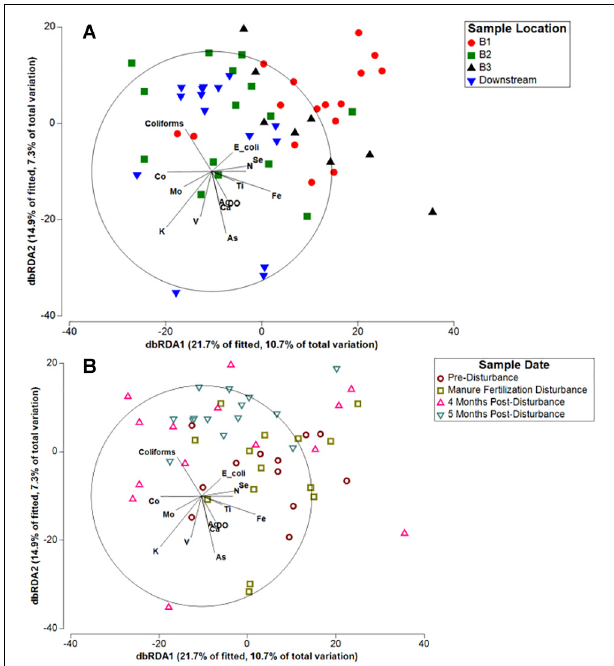
FIGURE 4 | Distance-based redundancy analysis (db-RDA) of Kewaunee County watershed sediment microbial communities in response to measured environmental factors clustered by (A) river sampling location and (B) sampling timepoint. Variables found to explain variation in microbial community composition that were at or near significance ( p < 0.1) and with moderate to strong correlations ( r 2 > 0.2) are displayed in the plot (for all variables in the model, see Supplementary Table S2